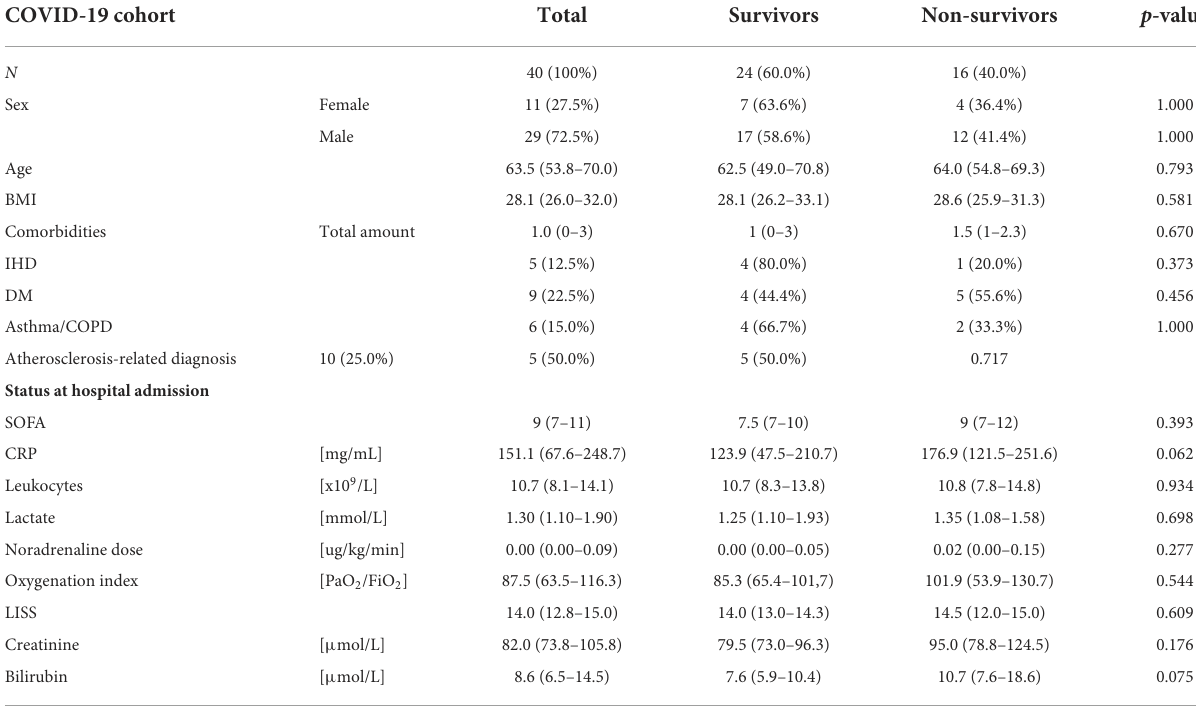
TABLE 2 Demographic and clinical characteristics of patients in COVID-19 cohort. COVID-19 cohort Total